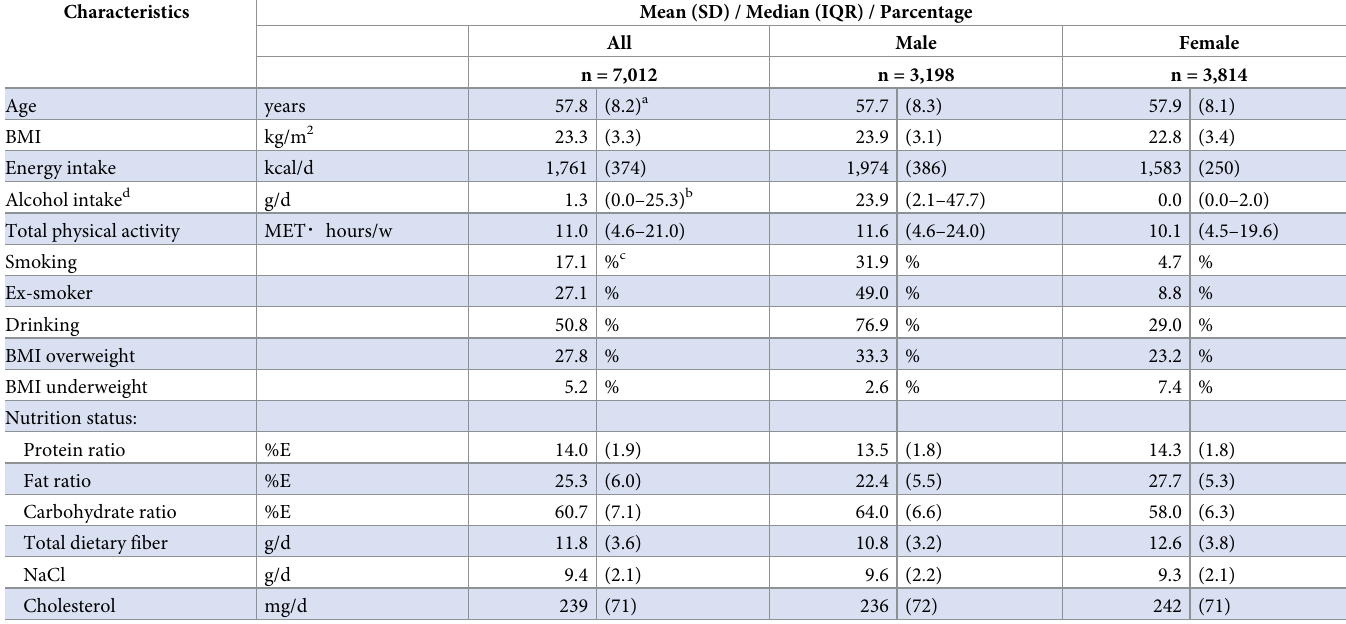
Table 1. Characteristics of the target